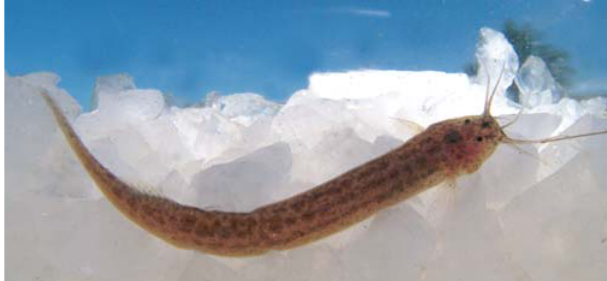
Fig. 6. Ituglanis cahyensis , new species. Specimen photo- graphed alive in a field aquarium shortly after